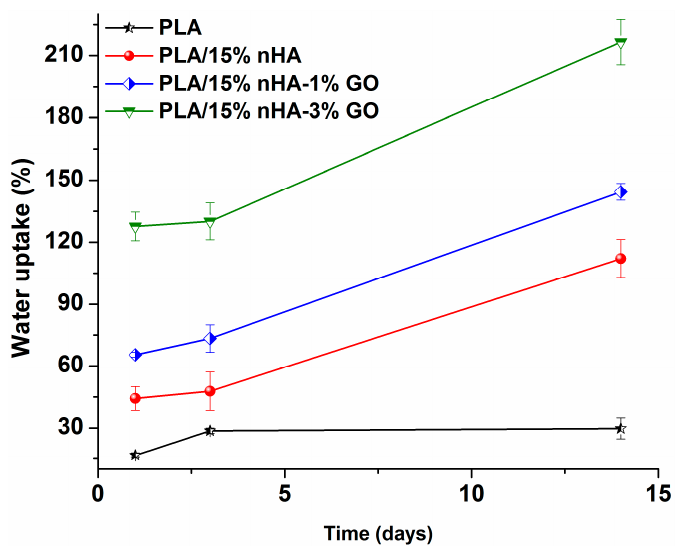
Figure 10. Water absorption behavior of PLA and PLA-based composite nanofiber mats.